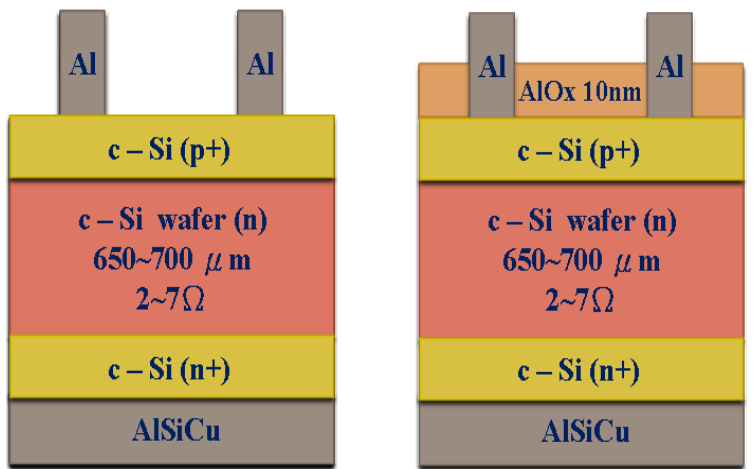
and with AlO x x